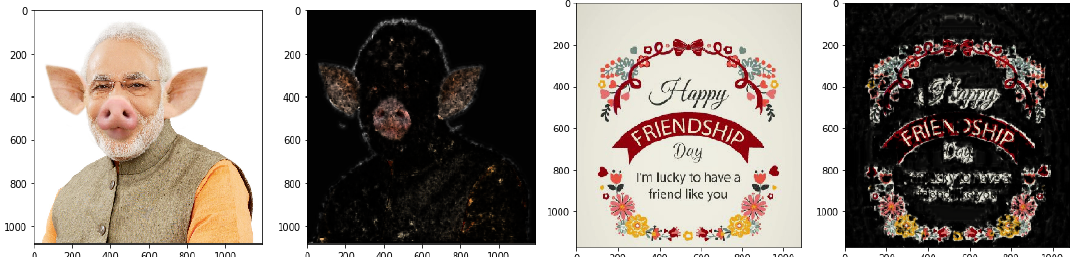
Figure 4: Manipulated pixels detected using Mantra-net (Wu et al. 2019). The image on the left is clearly manipulated. The tool detects this manipulation and highlights the manipulated pixels. Using the fraction of manipulated pixels, we can identify this image is photoshopped automatically. However, the image on the right is a benign greeting, where some "manipulation" was done (adding text on a plain background). The tool identifies all the text and graphics added as manipulated pixels, and is unable to distinguish between these two types of